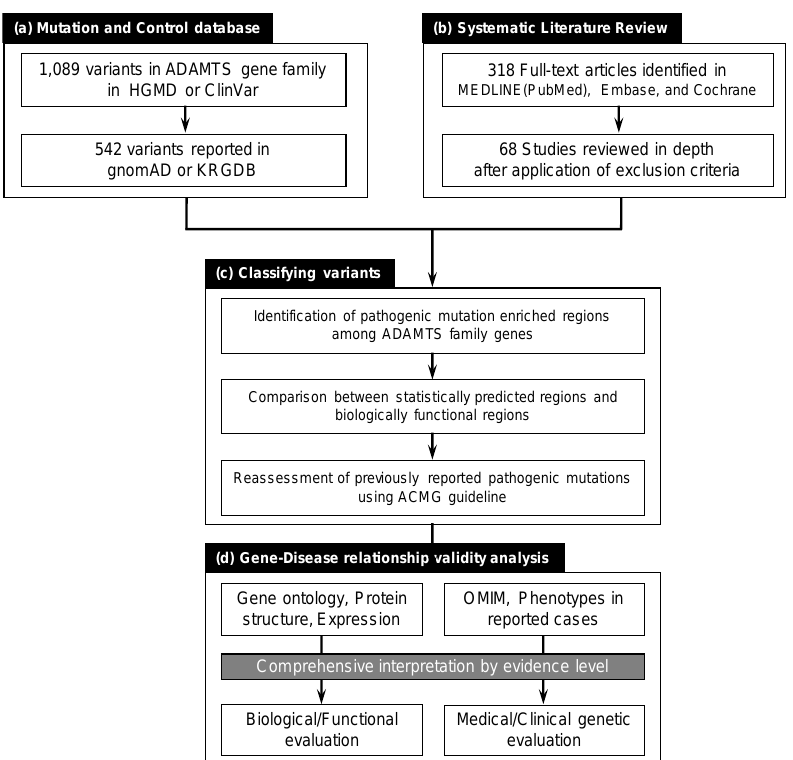
Figure 1. The overall workflow of the study. ( a ) ADAMTS family gene variants reported in public mutation and control databases were compiled. A total of 1089 variants were deposited in the Human Gene Mutation Database (HGMD) and ClinVar. Variants reported as “likely pathogenic” or “pathogenic” in ClinVar and as “DM” or “DM?” in HGMD were further examined. Of the 1089 variants, 541 were reported in gnomAD and KRGDB control datasets. ( b ) Systematic literature review in MEDLINE (PubMed), Embase, and the Cochrane Database of Systematic Reviews electronic databases revealed 318 full-text articles as of January 2020. Only 68 studies fulfilled our criteria and were fully reviewed in depth by two independent authors. ( c ) Variant classification, according to ACMG guidelines, along with mutation enriched region assessments using two different algorithms, were performed. ( d ) Evaluation of gene–disease relationships based on comprehensive evidence level interpretation were applied to all ADAMTS family